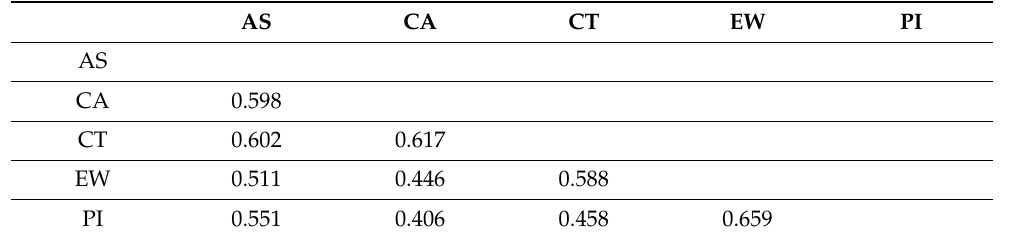
Table 8. Heterotrait-monotrait ratio (HTMT) correlation.